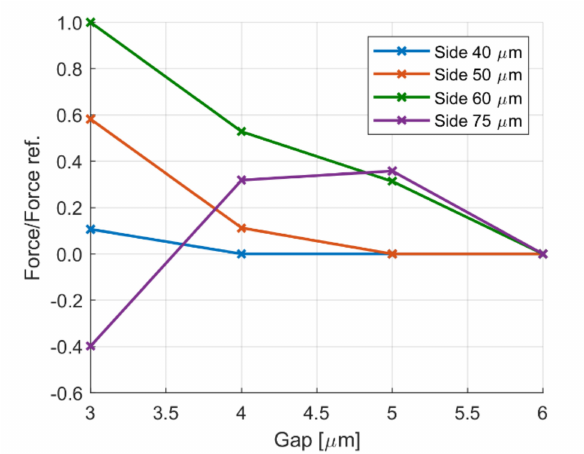
Figure 7. Bearing capacity is generated by a square dimple. Influence of the gap for di ff erent sizes of the dimple. Dimple depth 10 µ m, sliding velocity 5 m / s.